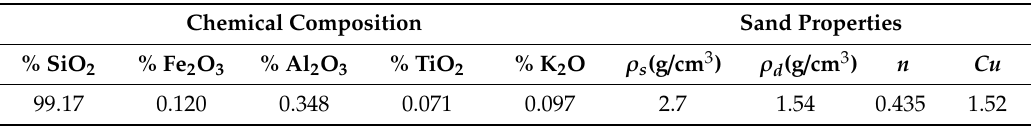
Table 1. The material